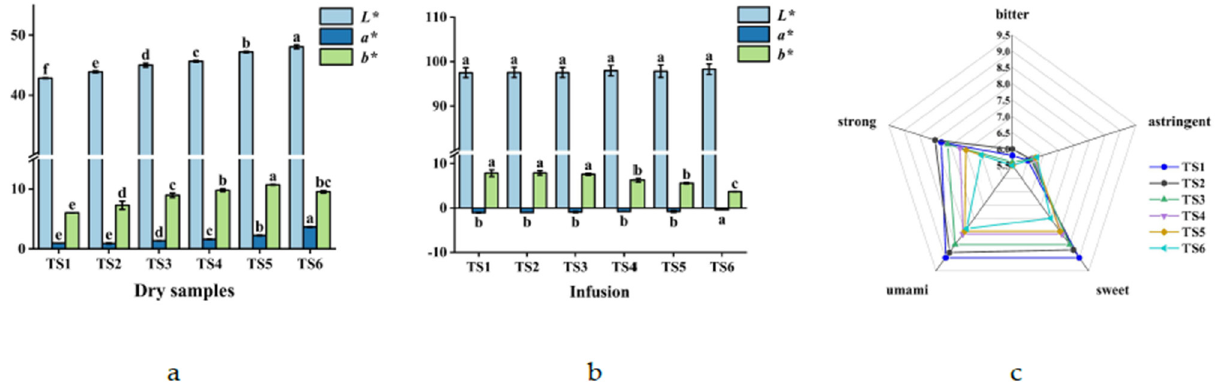
Figure 3. Differences in color between dry stem samples and stem infusions and sensory evaluation of stem infusions. ( a ) Difference in the colors of dry stems; ( b ) Difference in the colors of stems infusions; ( c ) Sensory evaluation of stems infusions. Different superscript letters denote significant differences ( p <